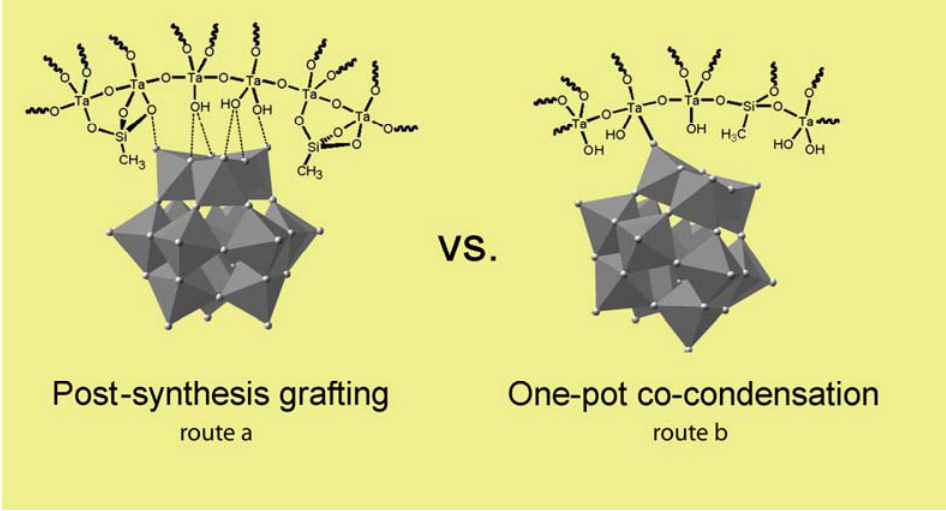
Figure 5. 3D interconnected mesoporous organic–inorganic hybrid catalysts prepared via dual functionalization through (a) post-synthesis grafting (b) one-pot co-condensation